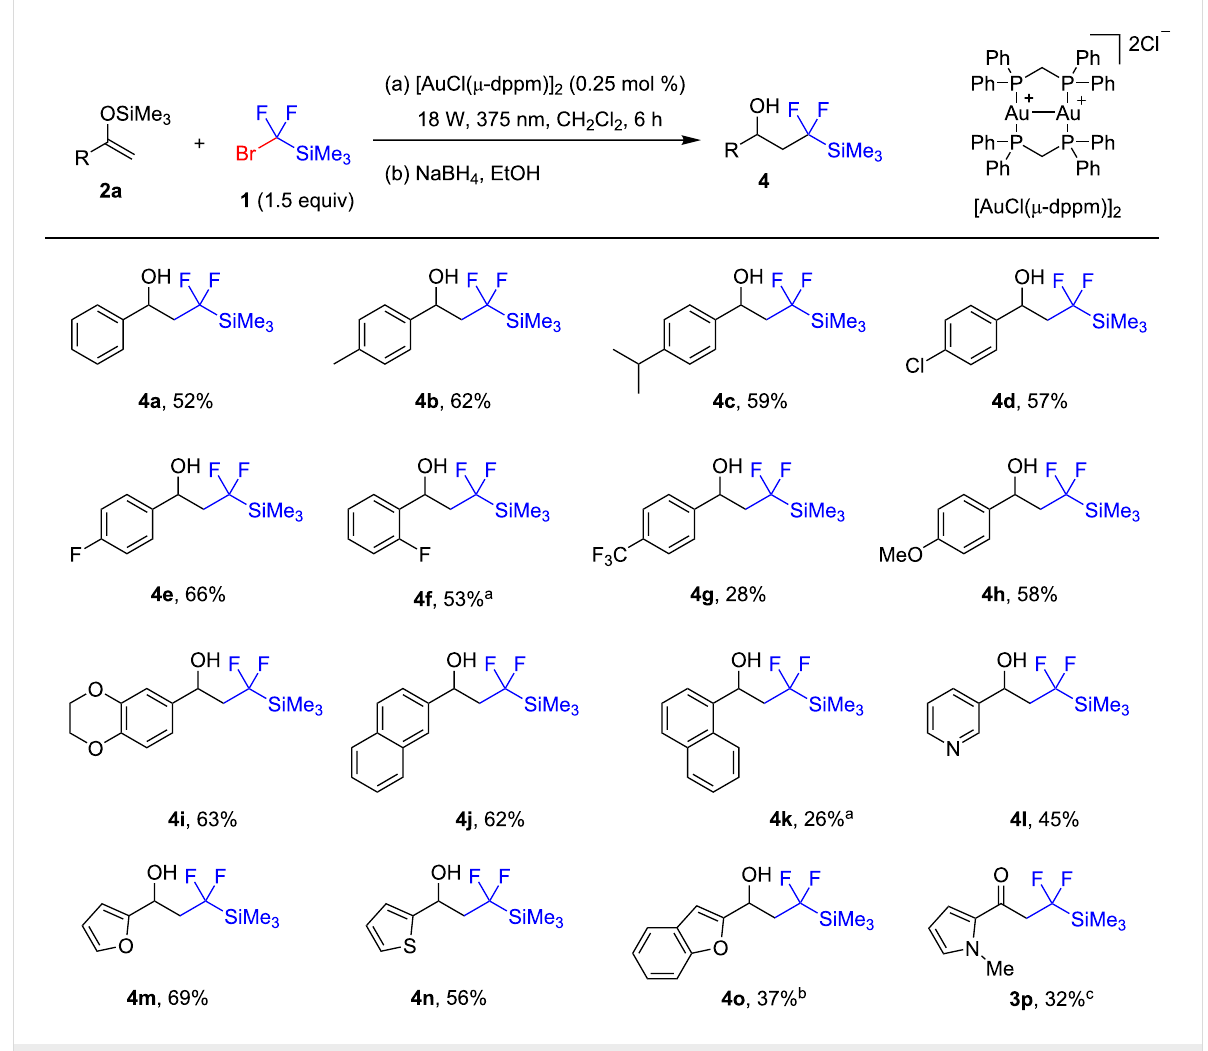
Figure 1: Reaction of silyl enol ethers. Yields refer to isolated yields. a Reaction time 24 h; b 1.0 equiv of silane 1 was used; c ketone was isolated.